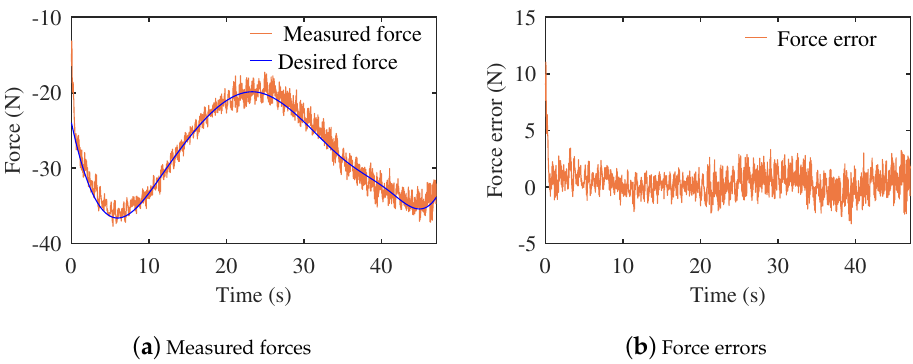
Figure 10. Measured force and force errors under off-line force control. When the robot executes the contact task under motion modeled by DMP, it is con- trolled to obtain the desired motion and force by the the same motion controller of the second subtask as in the first experiment. Compared with the parameter of admittance controllers in the first experiment, the parameters of admittance controller C are the same. In the experiment, the robot reproduced the contact task under no interactions. The contact force and force error were obtained as shown in Figure 11. The biggest force error was 3.57 N, and the root mean square error (RMSE) of the force was 1.36 N. The experiment was also repeated ten times under the same parameters of admittance controller C. The RMSE of the contact force was 1.11 N for the ten repeated experiments. The results of force and force error are close to those of off-line motion planning for the motion modeled by DMP. Compared with methods of the off-line and DMP motion planning, the proposed method obtains a similar RMSE of force.